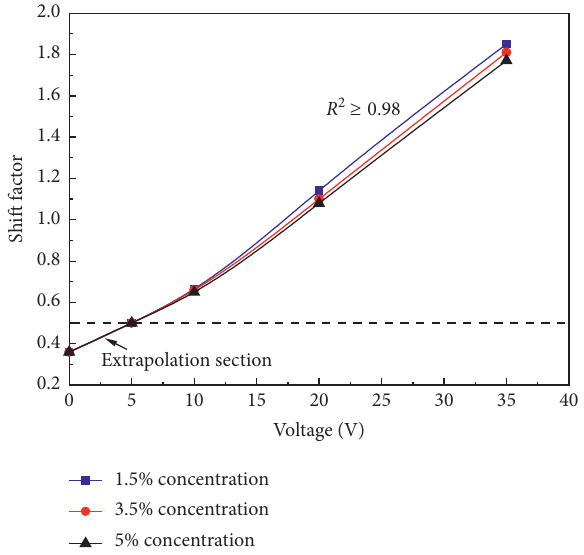
Figure 9: The derivation of the shift factor of 0 V.